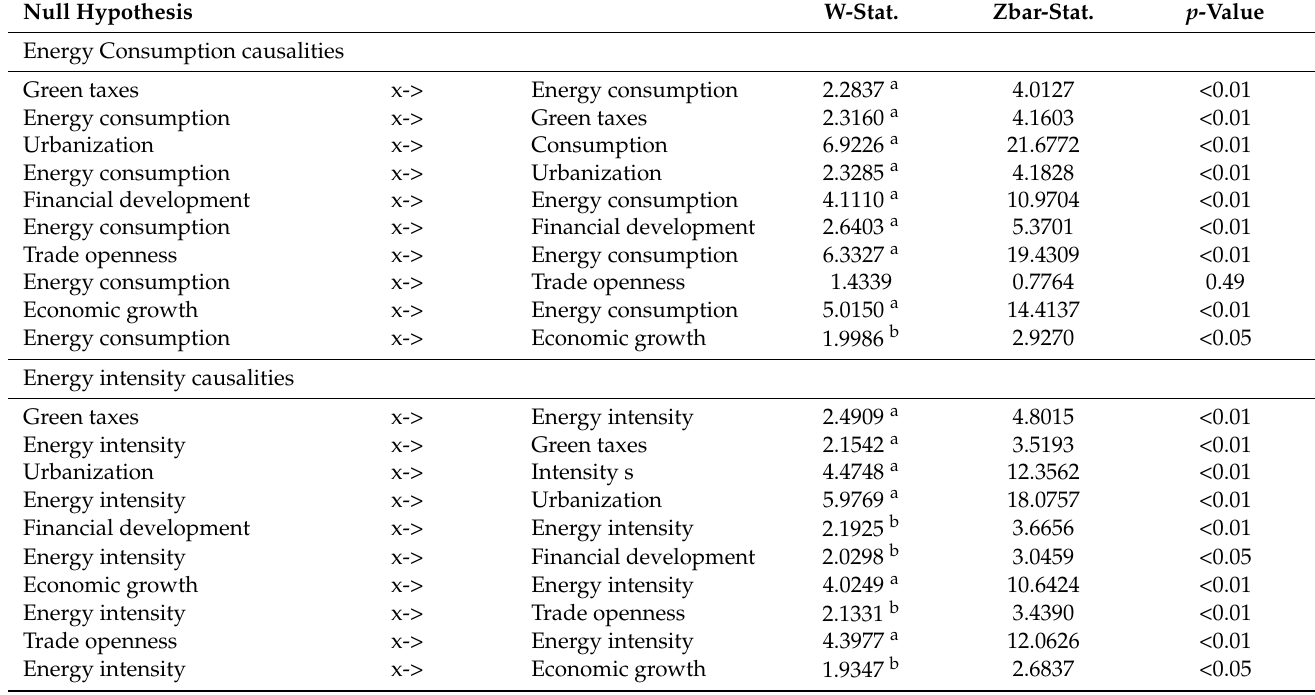
Table 8. Dumitrescu and Hurlin Causality